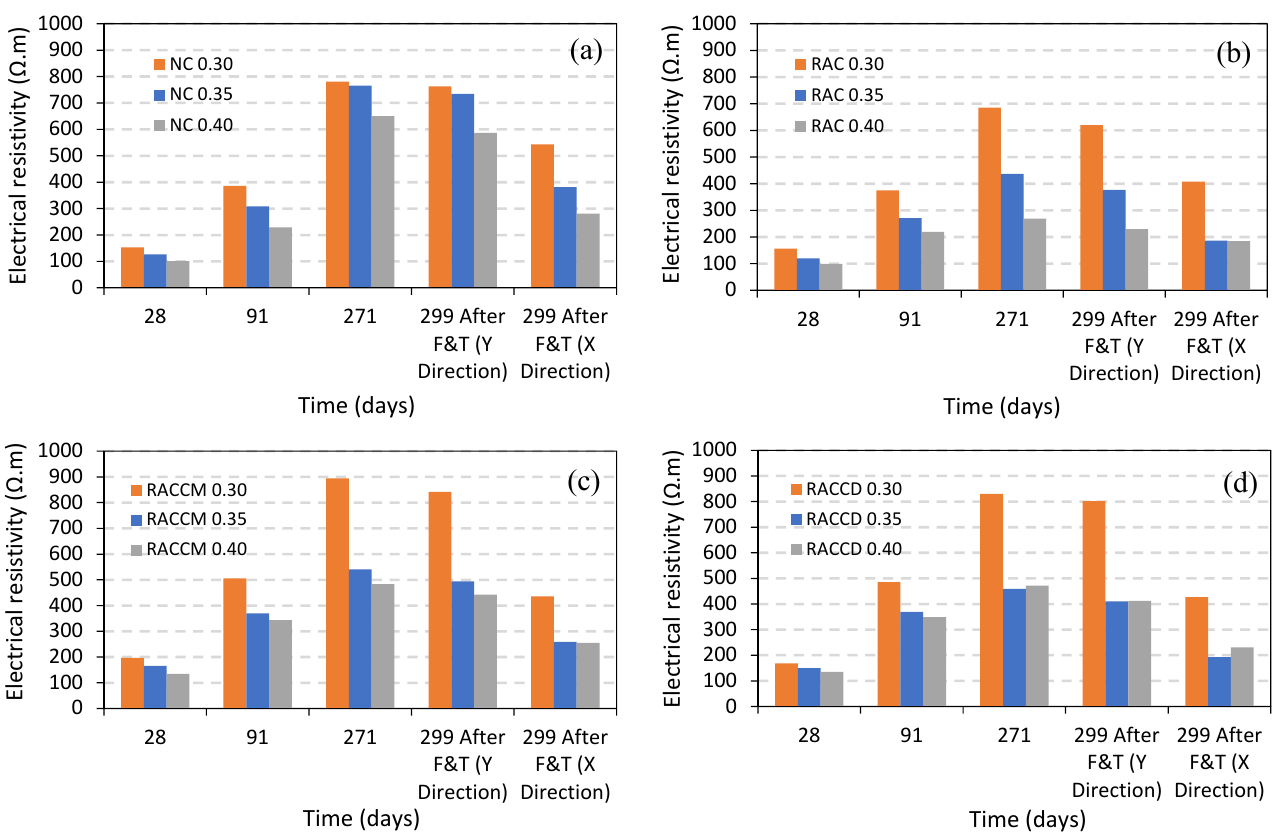
Figure 15. Effect of water–cement ratio on electrical resistivity of mixes before and after exposure to cycles of freezing and thawing; ( a ) normal concrete, ( b ) RAC group, ( c ) RACCM group, and ( d ) RACCD group.